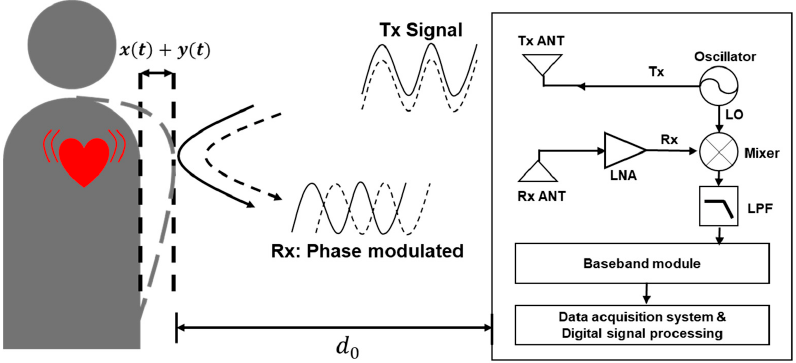
Figure 1. Block diagram of the continuous-wave (CW) Doppler radar sensor for vital-sign detection.